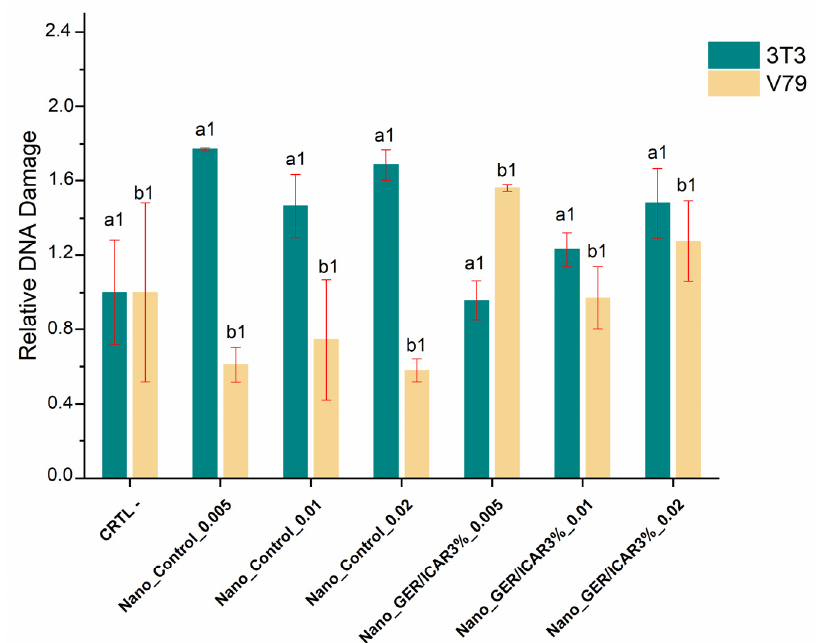
Figure 13. DNA damage assessment by the comet assay in cell lines: 3T3 and V79 exposed to concentrations of 0.005; 0.01, and 0.02 mg/mL of the formulations Nano_GER/ICAR3% and Nano_S/Active. Equal numbers (a1, b1) are not statistically significant ( p > 0.05).